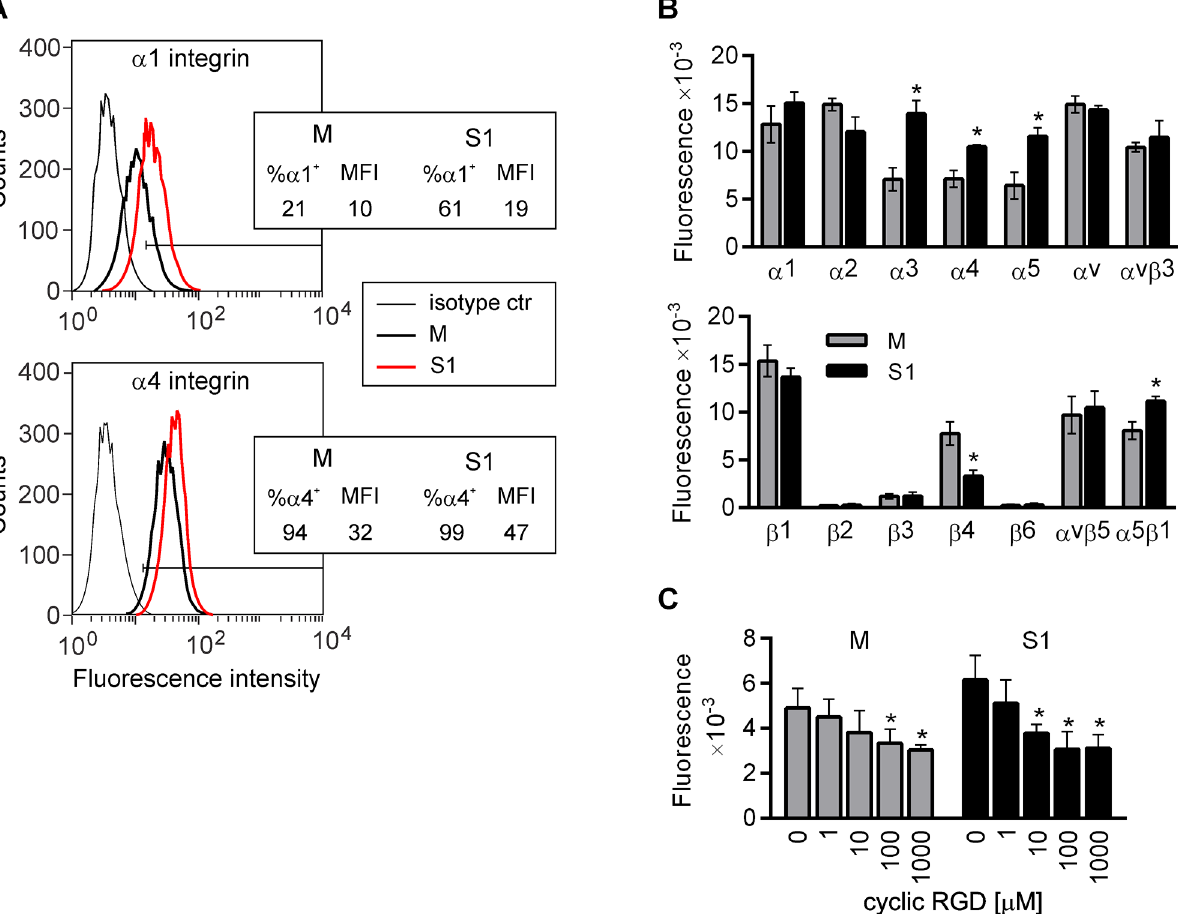
Fig 8. Effect of ADAM17 silencing on surface availability of integrins and their involvement in lymphatic endothelial cell (LEC) adhesion. ( A ) Flow cytometric analysis of α 1 and α 4 integrin surface expression on M and S1 cultured at the same density. The percentages of α 4 integrin-positive cells, as well as the mean fluorescence intensities (MFI, geomean) are presented. A representative result of five independent analyses is shown. ( B ) Availability of particular integrin chains on the cell surface assessed by the level of cell binding to surfaces coated with specific antibodies. Bars represent mean fluorescence signals of CyQuant GR-stained DNA of the cells that interacted with a given antibody ± SD from two independent experiments performed in duplicates. * P < 0.05 vs M. ( C ) Inhibition of cell adhesion to fibronectin by cyclic RGD peptide analyzed by alamarBlue assay. Bars represent the mean fluorescence signals ± SD from three independent experiments performed in duplicates. * P < 0.05 vs control M or control S1.